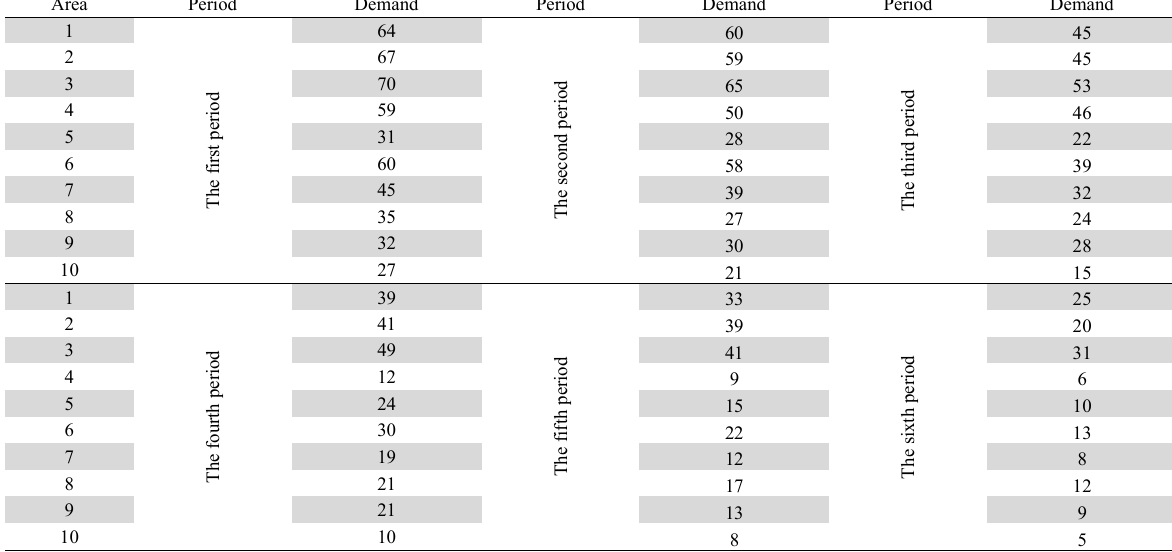
Demands for evacuating operations of 10 areas in Tehran region 1 for 6 time periods. Area